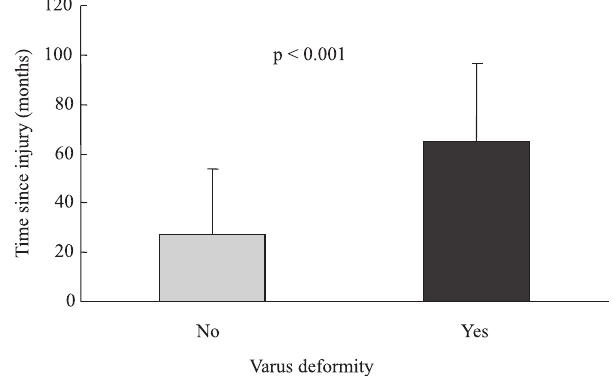
Figure 1 – Graph showing the time since injury for groups with and without varus deformity.